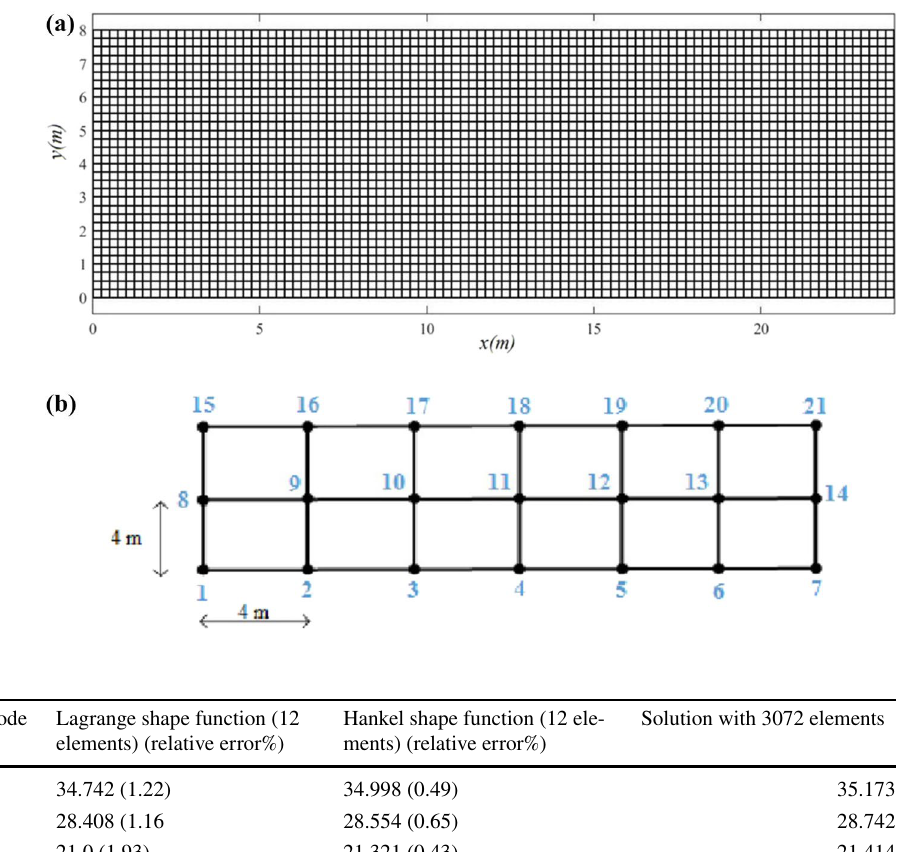
Table 3 Comparison of the results among Hankel shape function (12 elements) and Lagrange shape function (12 and 3072 elements) for the second problem